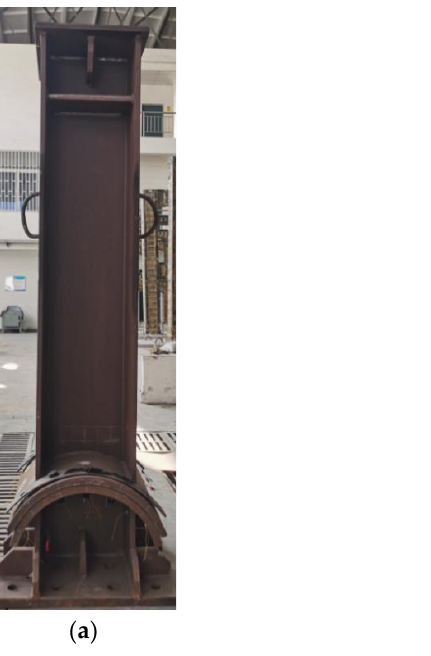
Figure 2. Sectional sizes of H-shaped section (unit: mm).